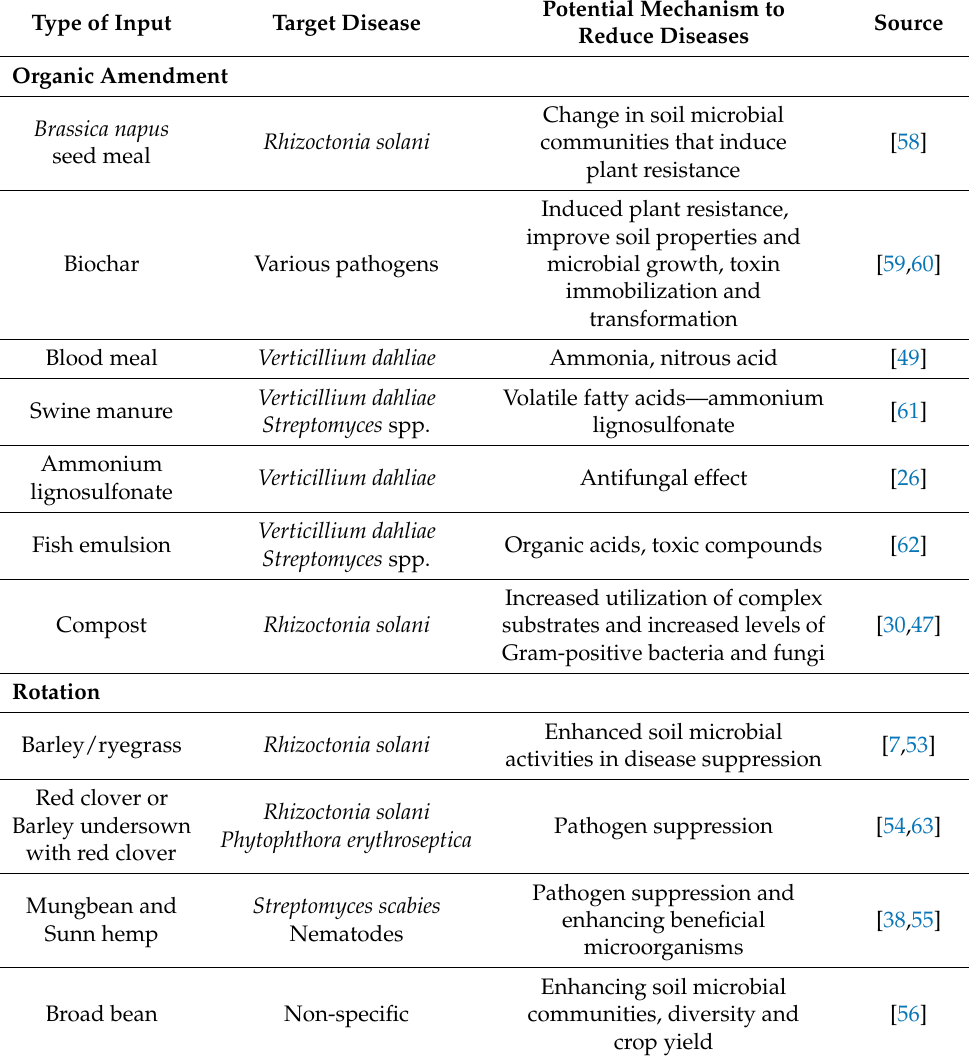
Table 1. Examples of soil amendments used for improving soil health based on individual